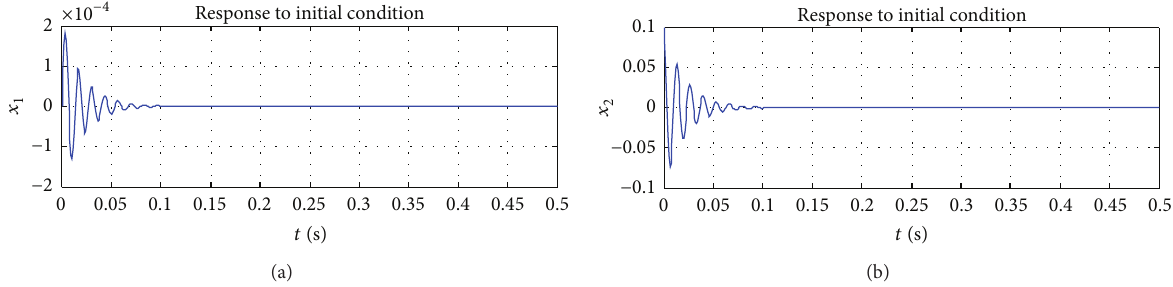
Figure 7: Closed-loop initial response of valve for optimal regulator designed with 𝑄 and 𝑅 = 1 .